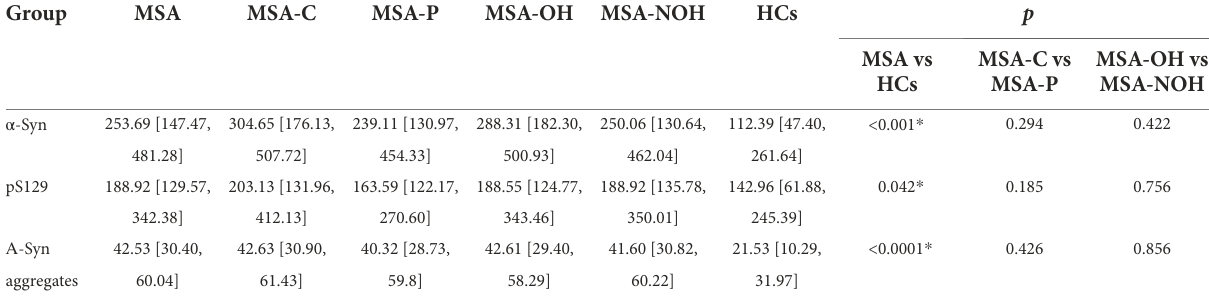
TABLE 2 The concentrations of α -Syn in oral mucosal cells of MSA and